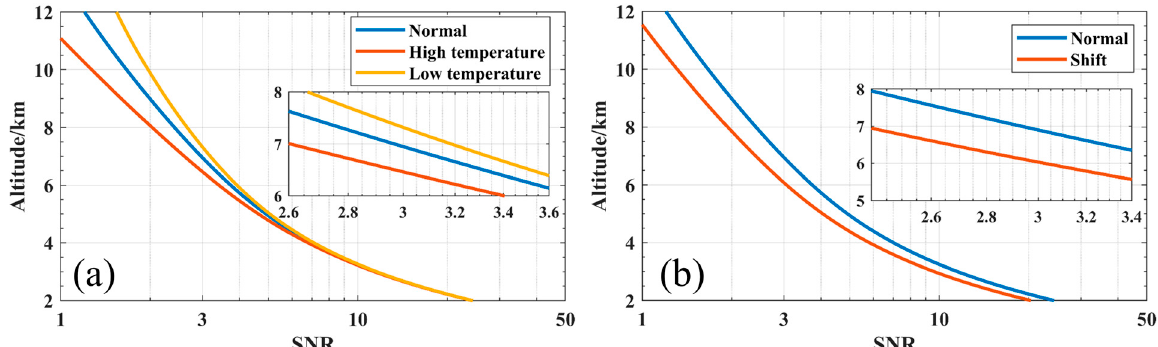
Figure 6. ( a ) Influence of Central wavelength of filter and ( b ) influence of dark count variation of APD on SNR at different temperature .